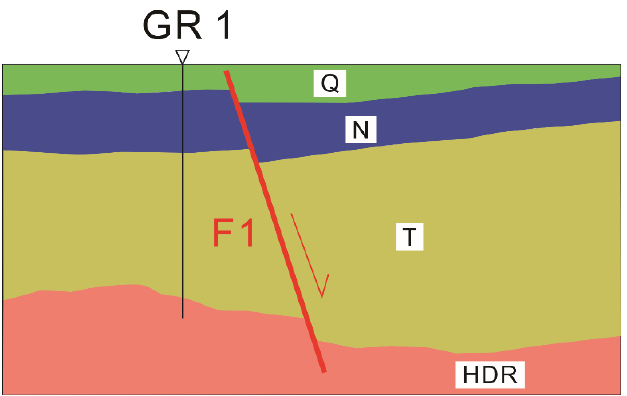
Figure 6. Geological interpretation of the WFEM data for Line L2.